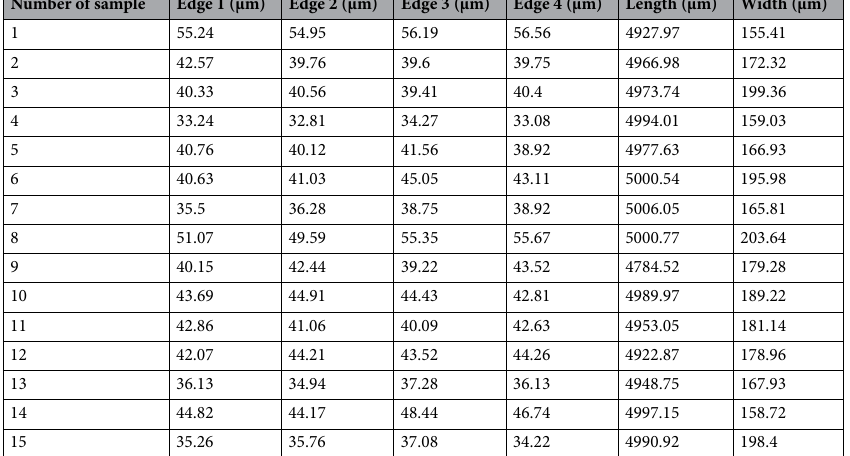
Table 2. Dimensions of individual slit shapes.